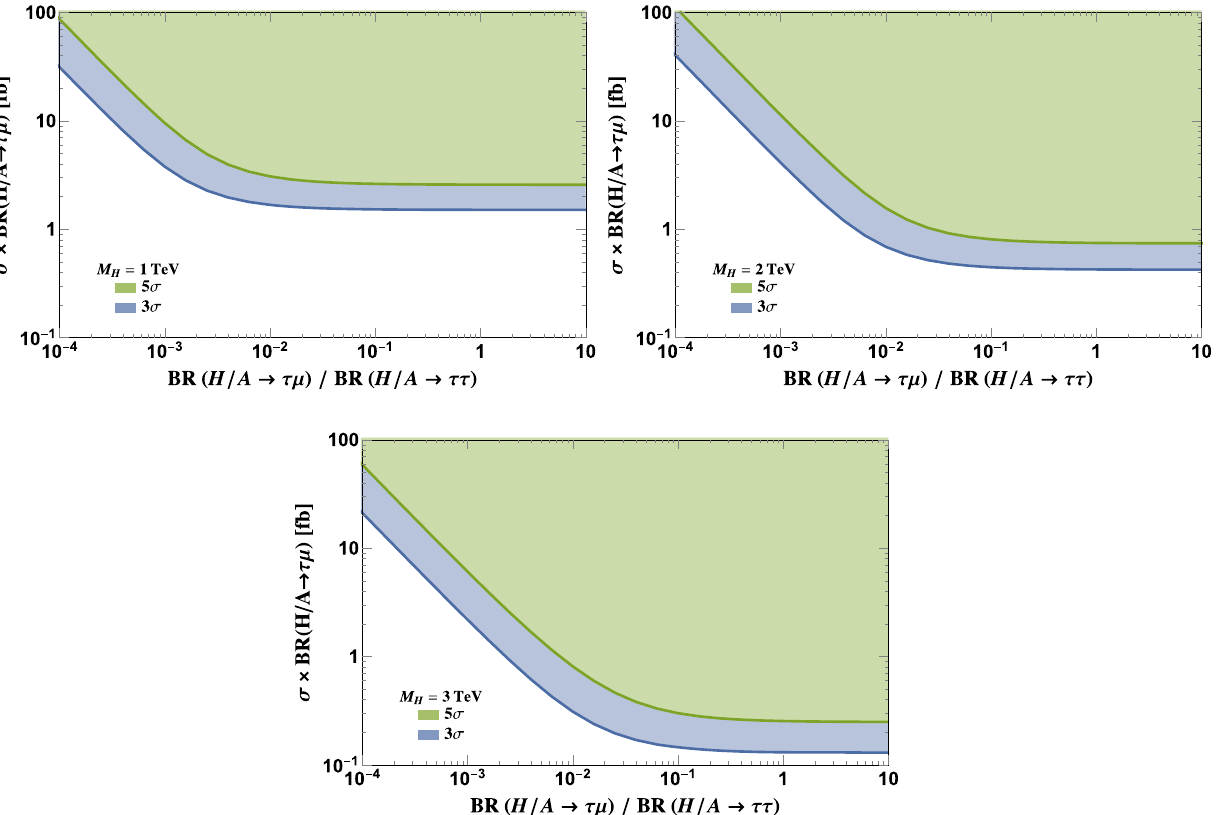
Fig. 5 3 σ (blue) and 5 σ (green) significances obtained with L = 300 fb − 1 for M H = 1 TeV (upper left), 2 TeV (upper right) and 3 TeV (bottom) when the ditau channel is included as